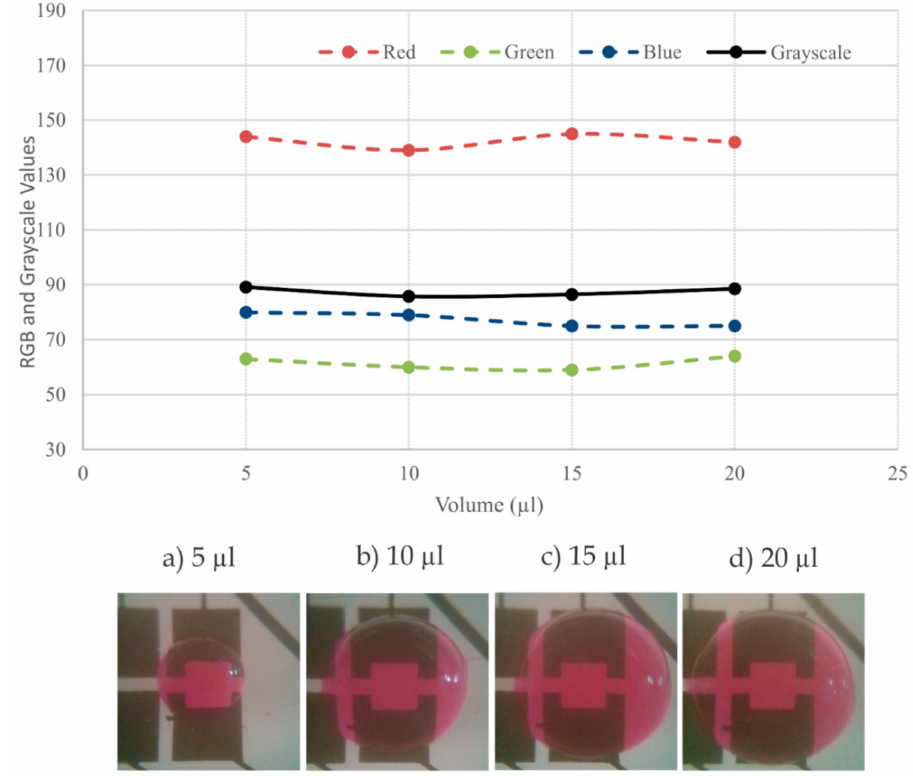
Figure 12. The change in the volume of the droplet did not have a significant effect on the droplet color measurements when the droplet volume was varied from 5 to 20 µ